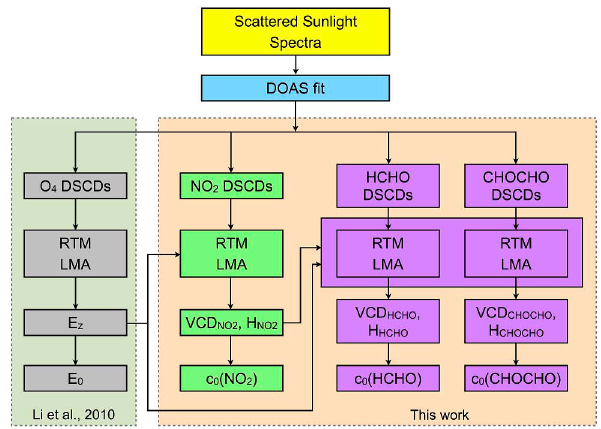
Fig. 2. Flow diagram of MAX-DOAS trace gas vertical distribution